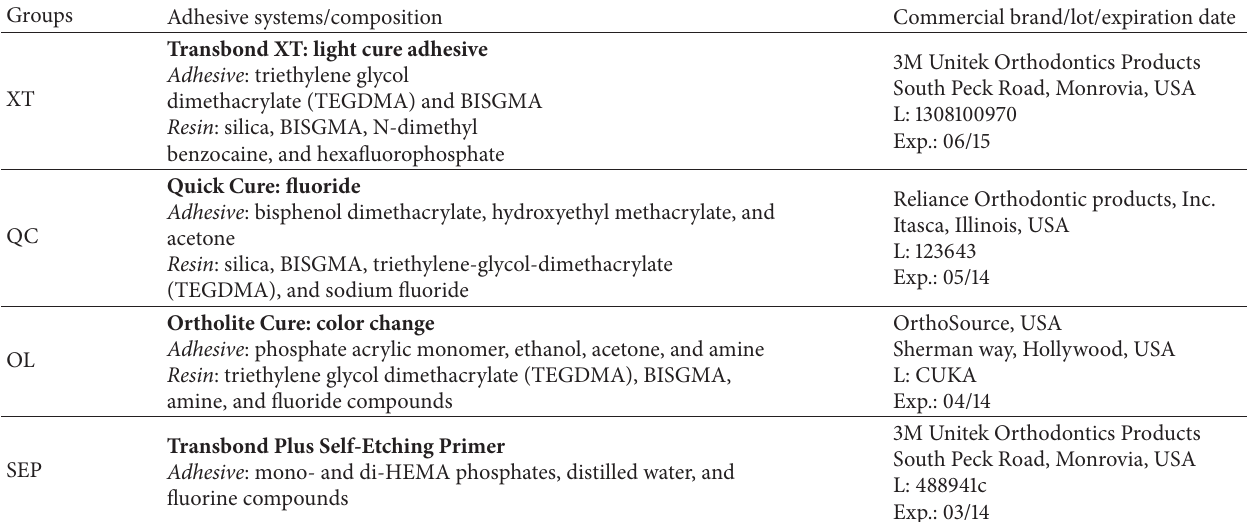
Table 1: Experimental